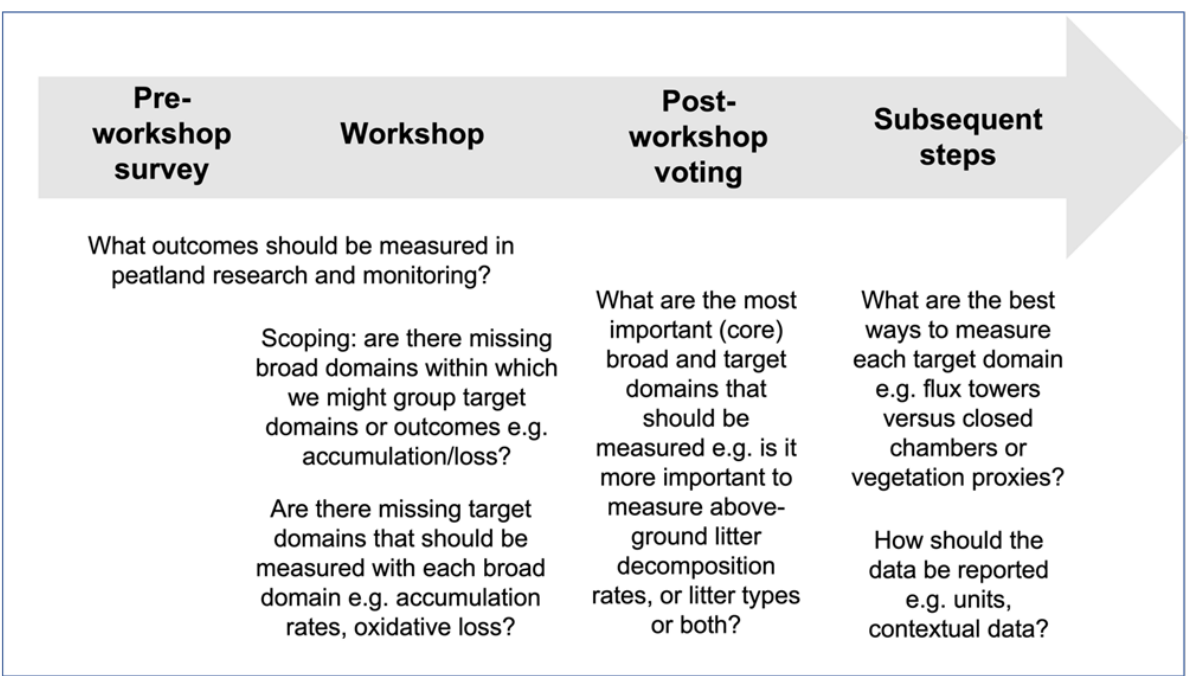
Figure 2. Methodological framework for agreeing core domain sets of standardised outcomes that should be measured in peatland research and monitoring (subsequent steps were not undertaken in the research reported in this